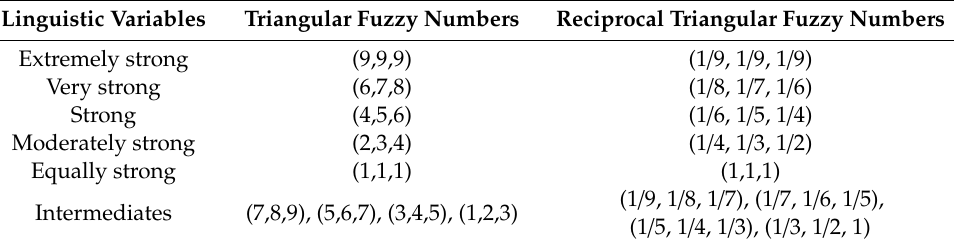
Table 3. The applied triangular fuzzy number of linguistic